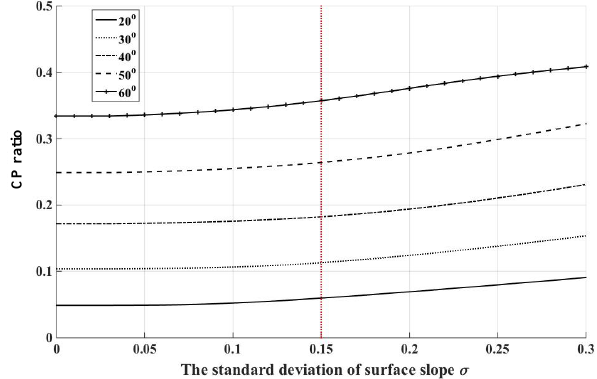
Figure 1. Variations of the CP ratio as a function of the stan- dard deviation of surface slope σ for different incidence angles and ε = 3.9 + j 0.15. The red line marks the maximum threshold of σ for the validity of our approach.